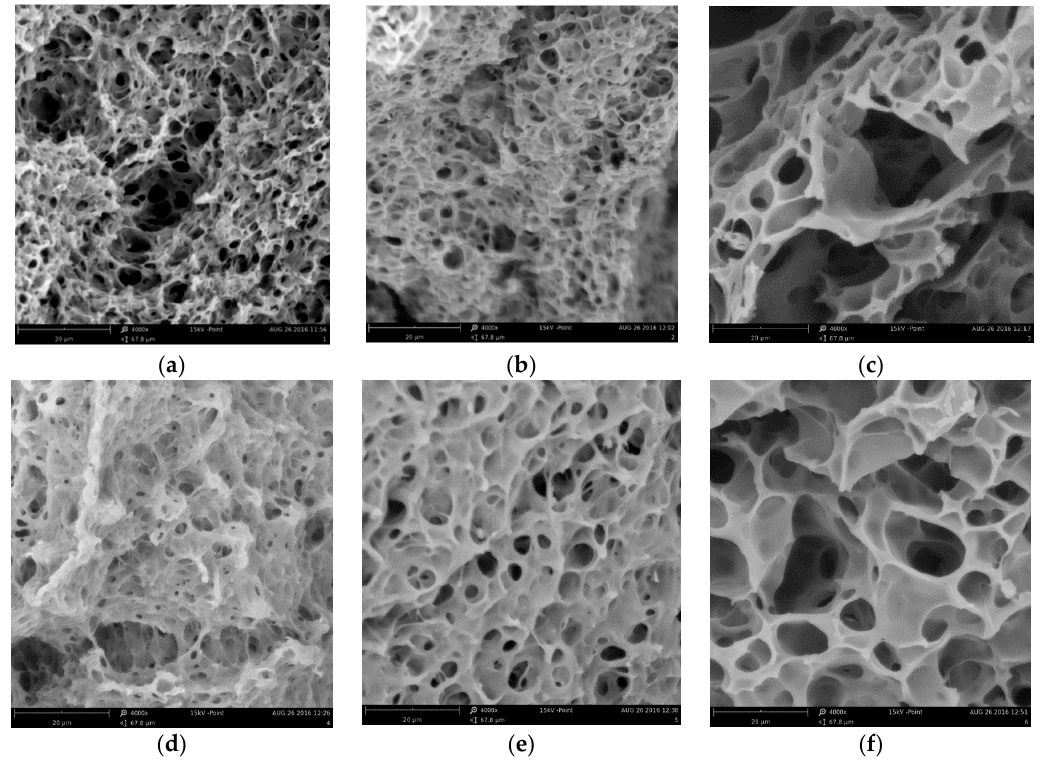
Figure 2. The SEM micrographs of PMMA-based sorbents (magnification 4000×): ( a ) PMMA1; ( b ) PMMA2; ( c ) PMMA3; ( d ) PMMA4; ( e ) PMMA5; ( f ) PMMA6.